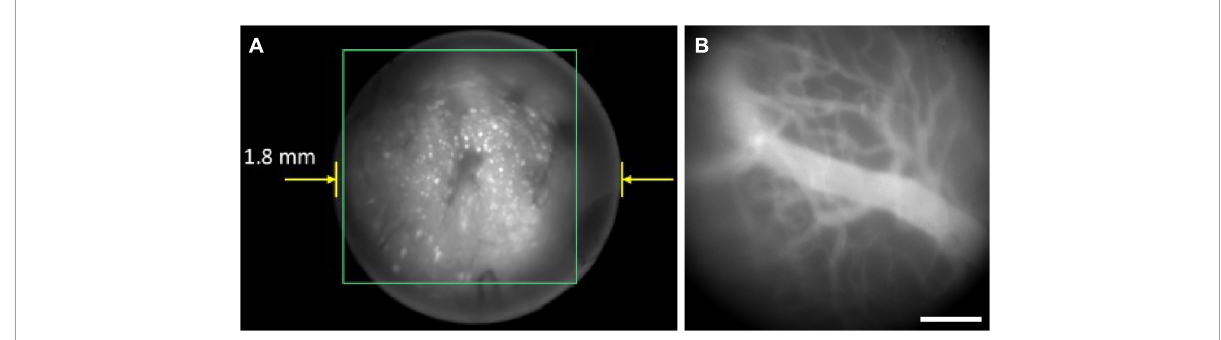
FIGURE3 Typical results of single-photon miniscopes. Background fluorescence greatly influenced the imaging quality. (A) CA1 neurons in freely behaving rat with Miniscope-LFOV. Reproduced with permission from Guo et al. (2021). (B) Blood vasculatures stained with FITC at the surface of mouse cerebral cortex, recorded with UCLA Miniscope V4. Scale bar, 200 µ